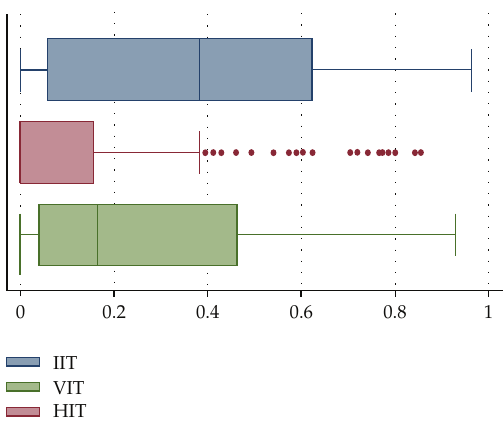
Figure 1: Trade between Portugal and European Countries for the period